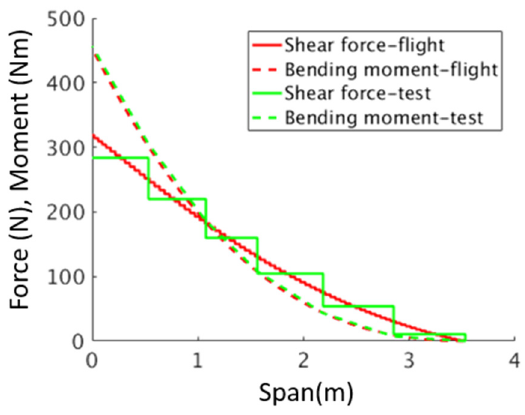
Figure 14. Derivation of the equivalent 1 g loads.